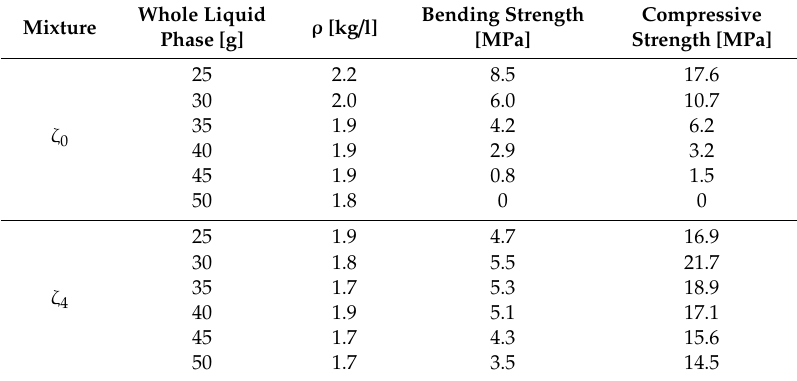
Figure 3. ( a ) Bending and compressive strength, and ( b ) density of AAM prepared with mixture ζ 0 (red) and mixture ζ 4 (blue), cured on 70 ◦ C for one day, measured one week after molding. Table 8. Density, bending, and compressive strength of AAM prepared with mixture ζ 0 and mixture ζ 4 , cured on 70 ◦ C for one day, measured one week after molding. Combination of ingredients for AA resulting in literature’s highest compressive strength value is